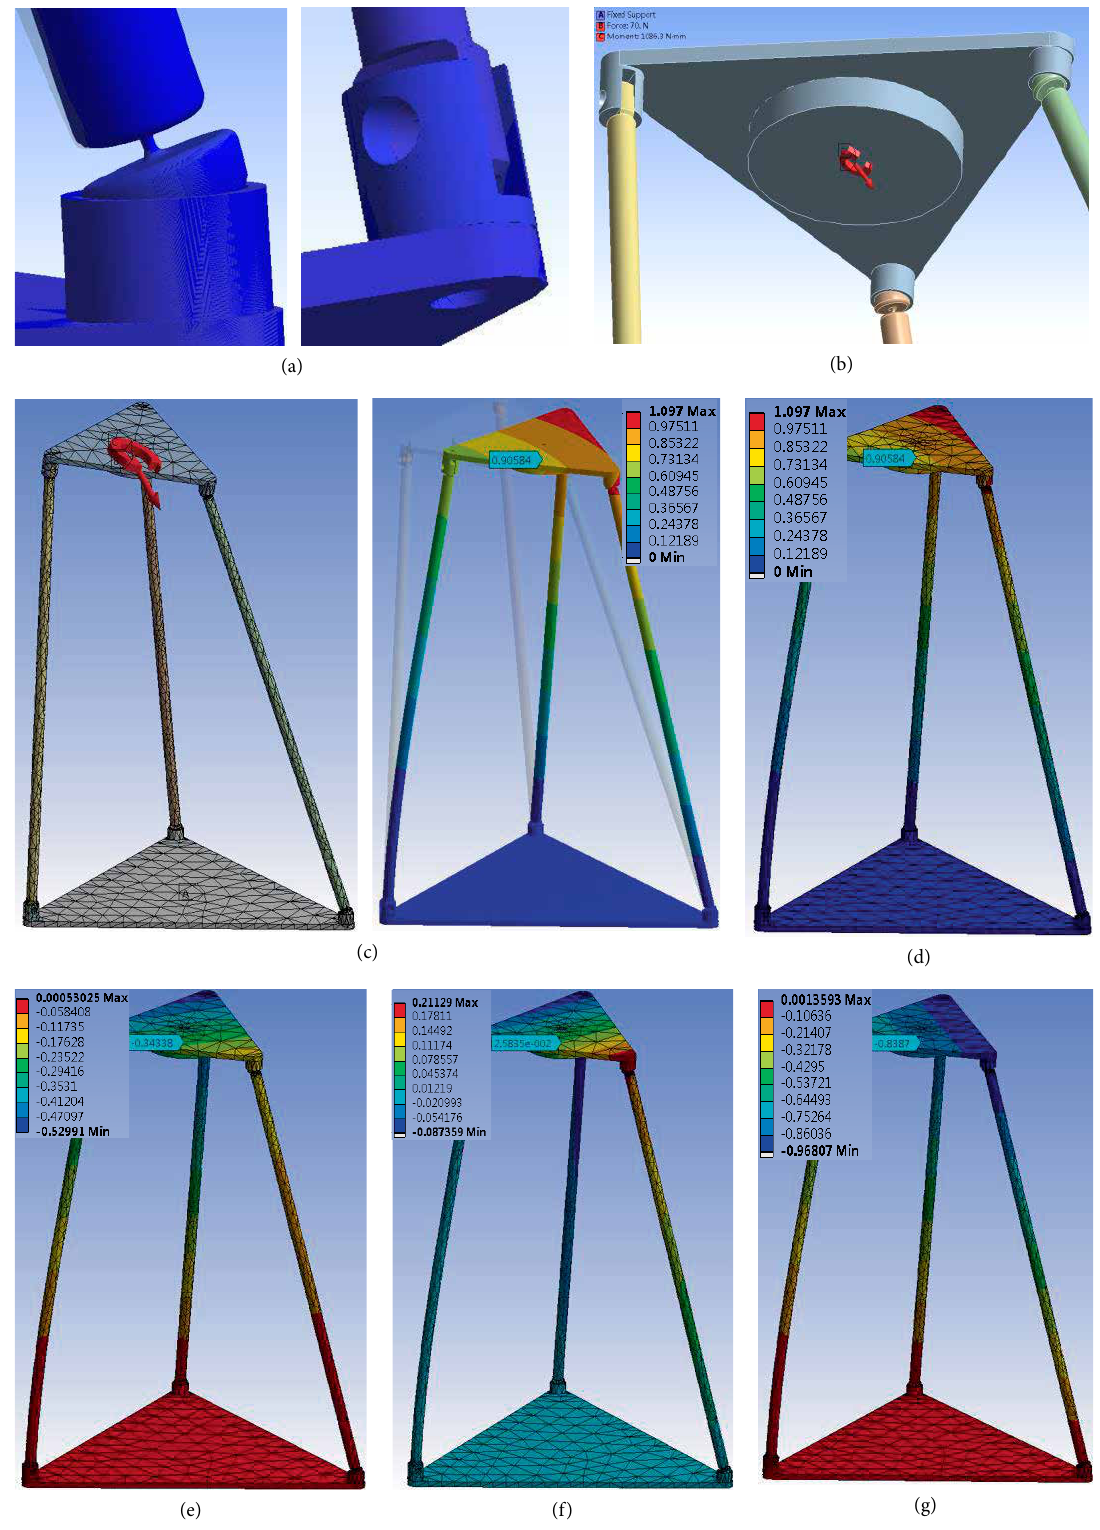
Figure 5: Simulation solutions of elastic deformations of EF model of the 2SPS + RRPR PM. (a) Equivalent spherical joint and , (b) load condition, (c) FE model of 2SPS + UPR PM and its elastic deformation, (d) elastic deformation of 1 2 𝑅 𝑅 , (f) elastic deformation 𝑜 𝑑𝑋